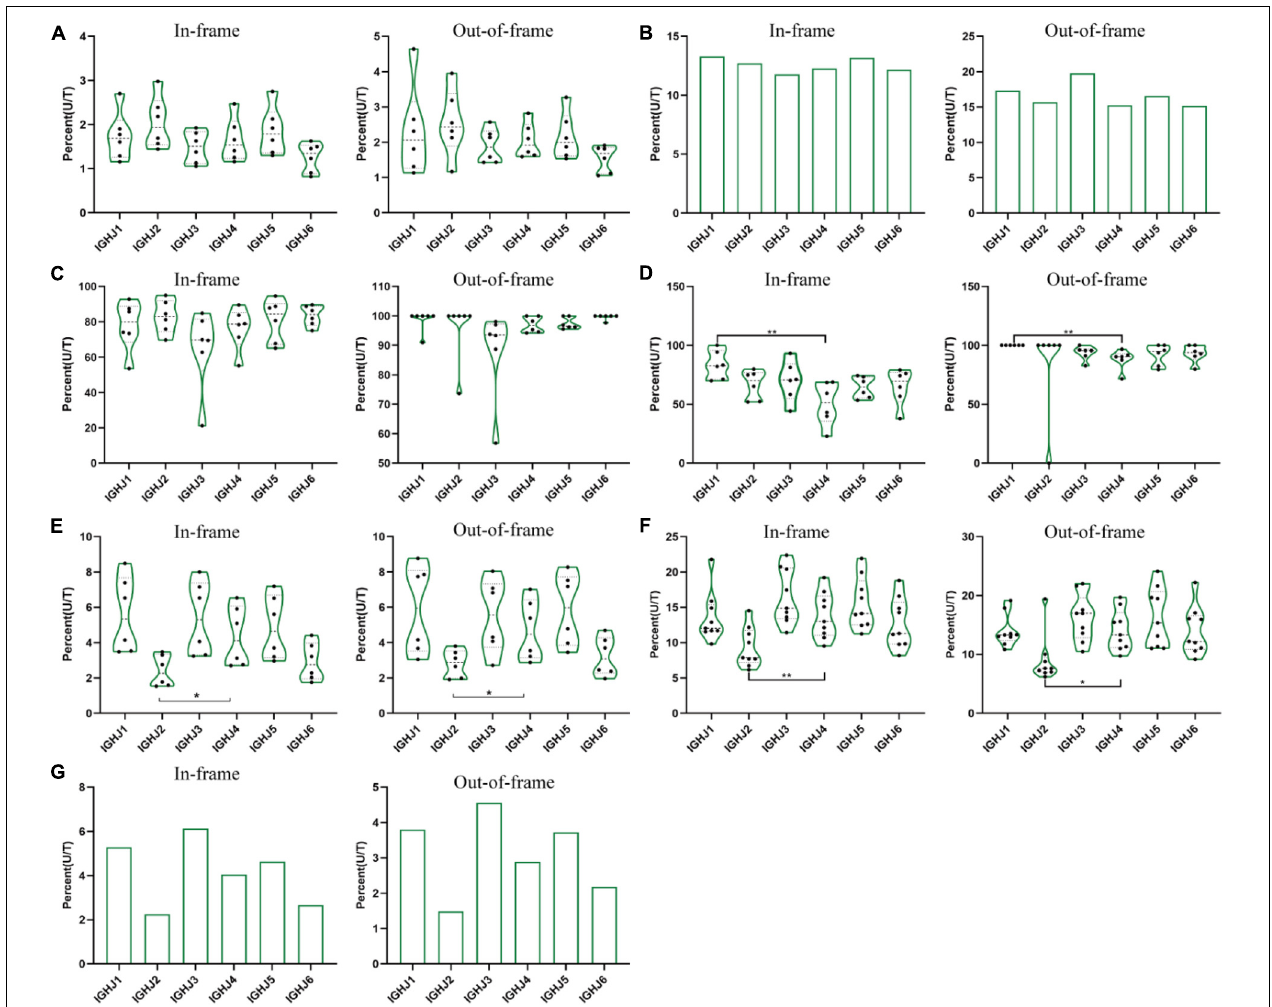
FIGURE 2 | The ratio of unique to total sequences (U/T) of 6 IGHJ genes in the in-frame and out-of-frame BCR-H repertoires from different subjects. (A) The IGHJ U/T ratio of BCR-H repertoires from 6 Healthy volunteers. (B) The IGHJ U/T ratio of BCR-H repertoires from public data. (C) The IGHJ U/T ratio of IgM-H repertoires from volunteers before and after immunization with the HBV vaccine. (D) The IGHJ U/T ratio of IgG-H repertoires from volunteers before and after immunization with the HBV vaccine. (E) The IGHJ U/T ratio of BCR-H repertoires from SLE volunteers. (F) The IGHJ U/T ratio of BCR-H repertoires from breast cancer volunteers. (G) The IGHJ U/T ratio of BCR-H repertoires from volunteers with a high titer of HbsAb. We used bar chart for sample groups with n = 2 (B) and IMGT (C) , while used box plot for sample groups with n ≥ 3 using a one-way ANOVA with Bonferroni correction (A,D–G) . All statistically significant differences are indicated as * p < 0.05; ** p < 0.01, and *** p < 0.001.